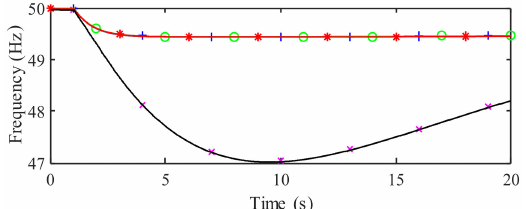
Figure 10. Frequency response as measured by the SG speed variation for VOC (black, solid line), VSM (red, * marked), VI (green, circle marked), and droop (blue, + marked) control systems, as well as no BESS connection (magenta, × marked).